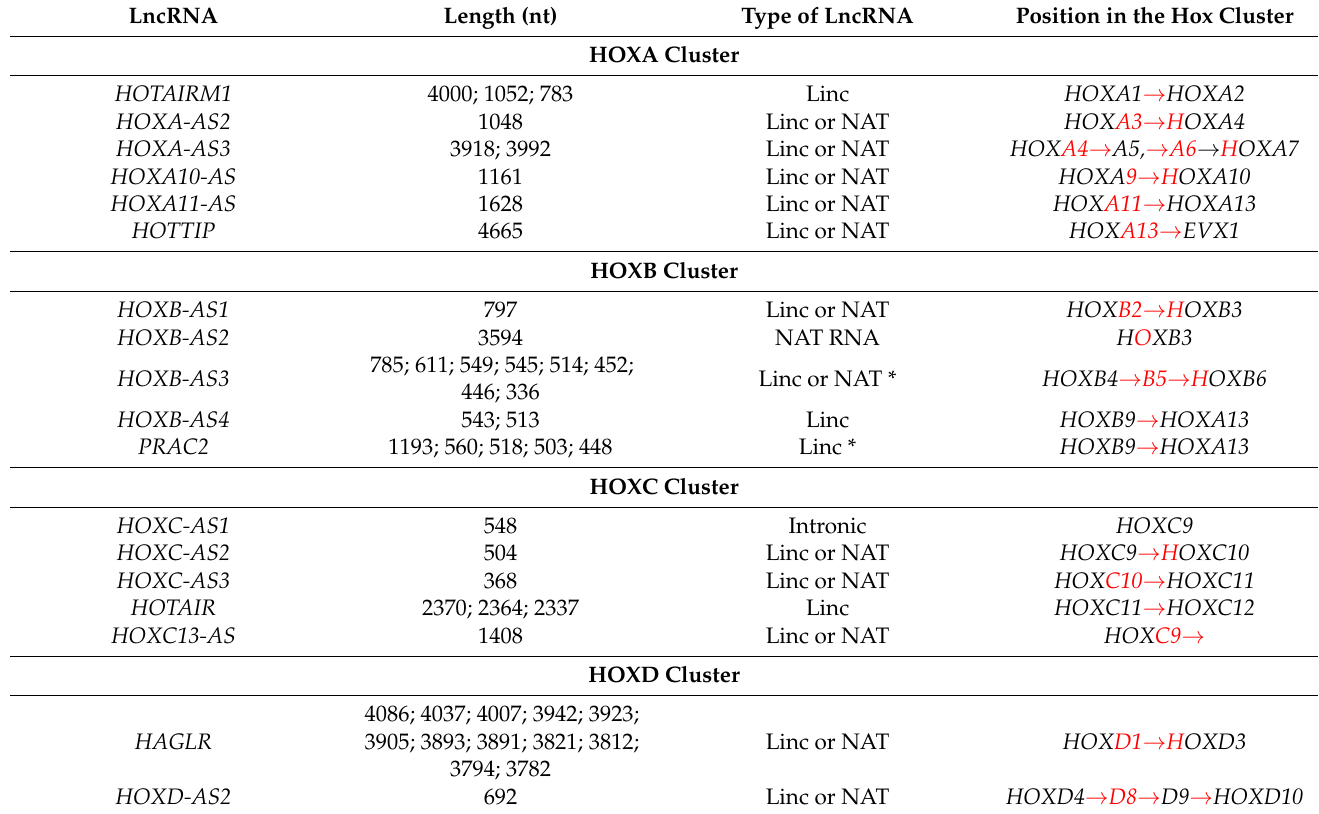
Table 1. Antisense lncRNAs from four human Hox clusters. The zones of the overlap of lncRNA exons and RNA exons from the opposite (template) strand are shown in